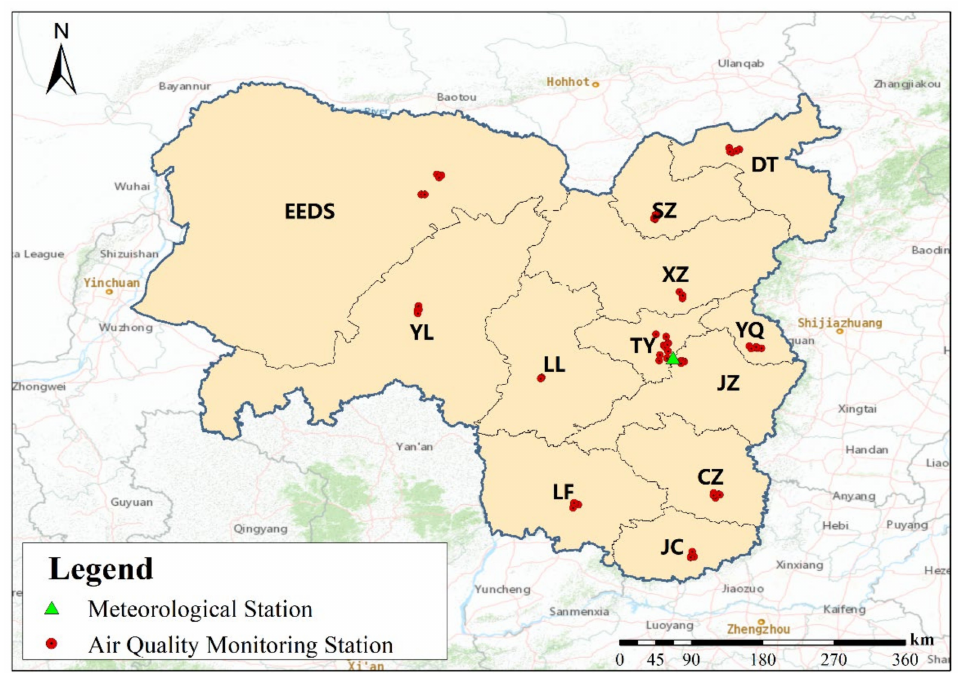
Figure 1. Air quality monitoring stations and the meteorological station in major coal production